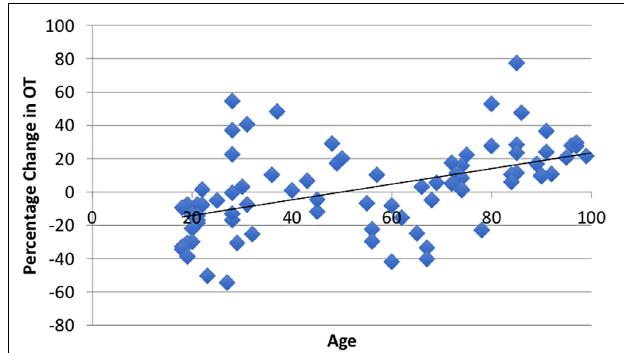
FIGURE 2 | There was a significant positive relationship ( r = 0.49, p = 0.001) between age and (cid:49) OT from the video stimulus. The video stimulus increased OT in 55% of the